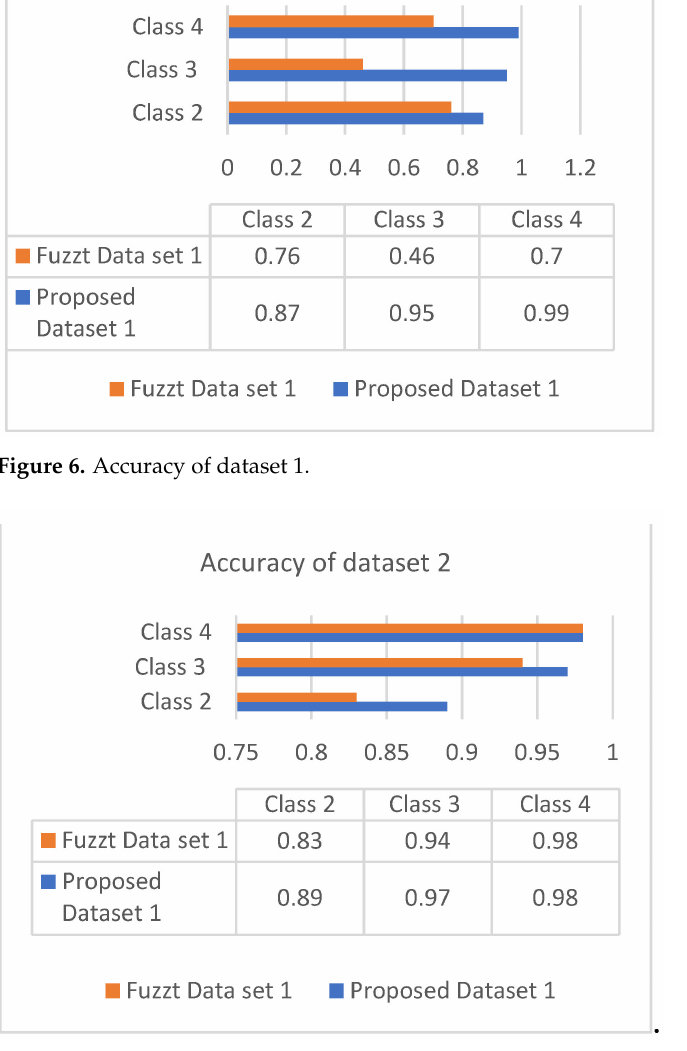
Figure 7. Accuracy of dataset 2.